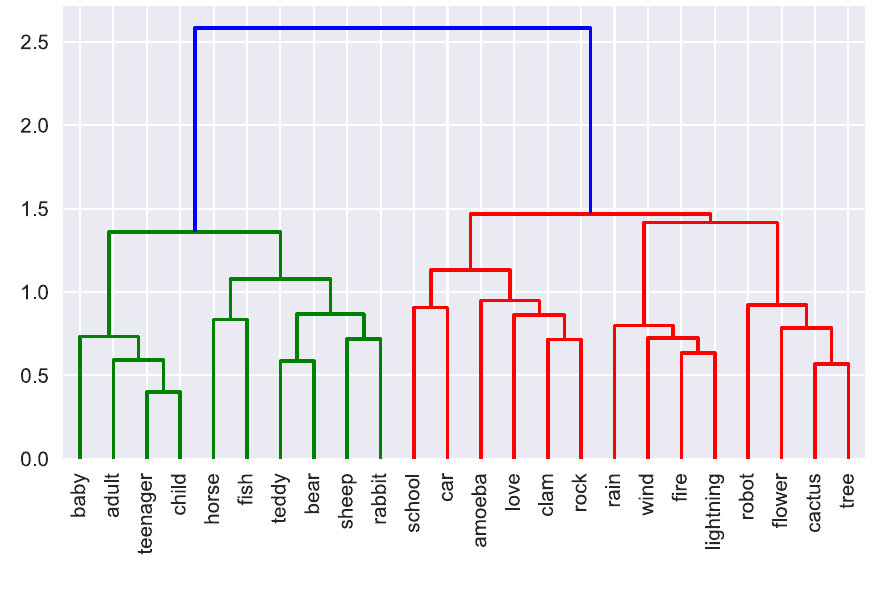
Figure 7 : Hierarchical cluster analysis of the similarity between nouns in the 100 languages in the second half of the experi- ment. As in the MDS plot in Figure 6, nouns are clustered together to the extent that they tend to bear the same noun affix. The major split shown here is between vertebrates (humans and higher animals) and others (invertebrates, inanimates and abstract